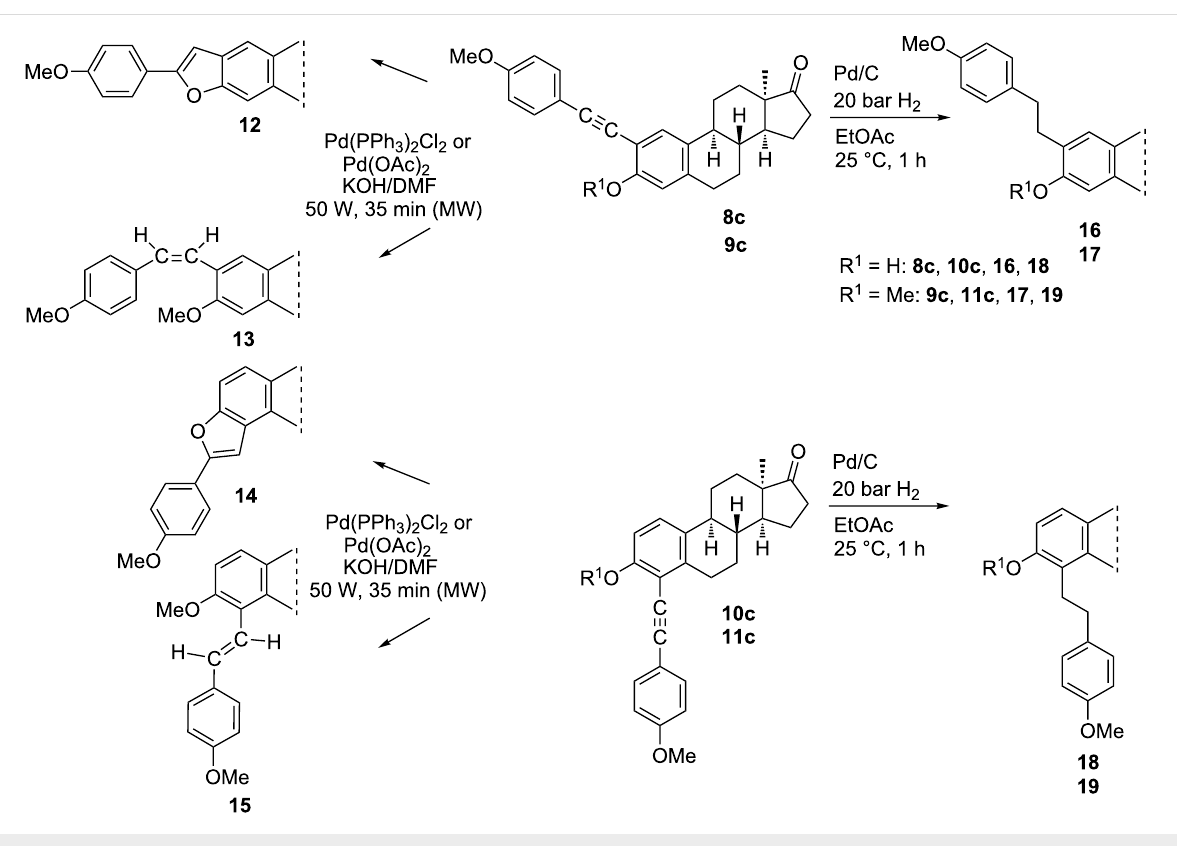
Scheme 2: Partial or full hydrogenation of compounds 8c – 11c